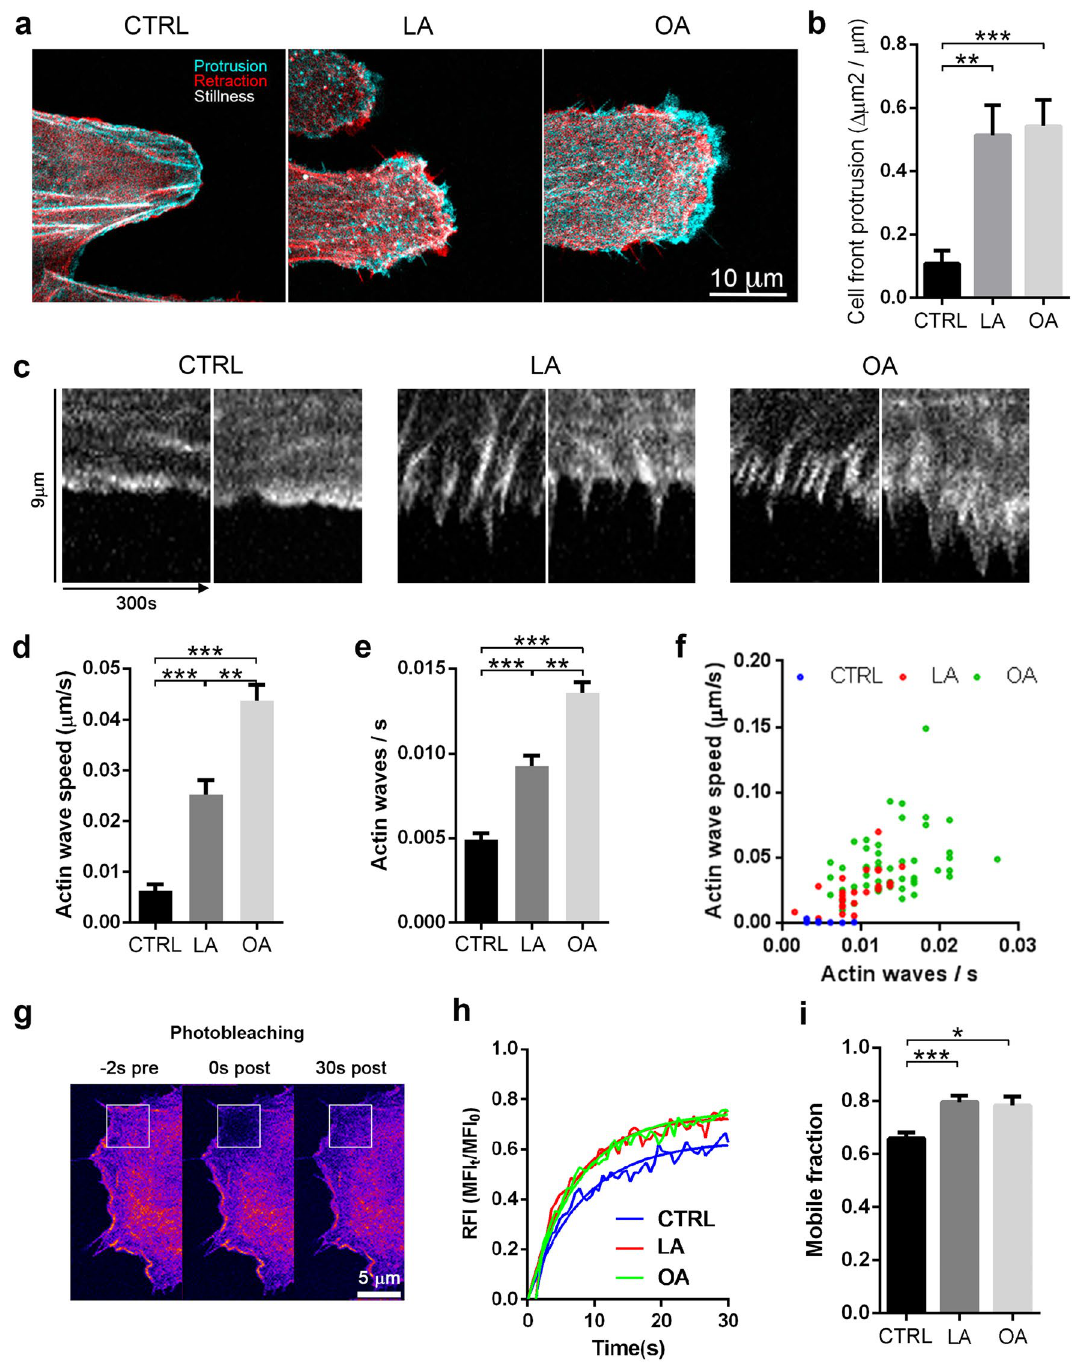
Figure 4. LA and OA increased the structure dynamic of actin at the migration cell front. ( a ) Superposition of confocal images of leading edges of live SKOV-3 LifeAct-GFP cells treated with vehicle, LA or OA, 4–6 h post scratch. Cyan represents the advance at the front, red shows retraction, and still actin structures are shown in white. Scale bar 10 μm. ( b ) The plots show the accumulated protrusions as obtained by superposition of images over a 5 min interval relative to the leading edge perimeter for each cell. ( c ) Kymographs of the leading edge during 5 min of time-lapse (two representative images per condition). Plots showing the mean ± SEM of ( d ) Actin wave retrograde speed and ( e ) wave frequency. ( f ) Correlation analysis shows that wave frequency and retrograde speed are positively correlated for LA and OA. ( g ) FRAP on the leading edge of the SKOV-3 LifeAct-GFP cells at three times: actin pre-photobleaching on the cell border (left), immediately after photobleaching (middle) and 30 s after the photobleaching, thus revealing recovery of fluorescence-signal (right). Scale bar 5 μm. ( h ) Exponential recovery curves from control (blue), LA (red) and OA (green) treated cells, and recovery rate was analytically obtained from the one-exponential function that best fitted the data. ( i ) Graph showing the mean ± SEM of the mobile fraction obtained from the FRAP experiments. Asterisks represent statistical significance (*p < 0.05, **p < 0.01, ***p <